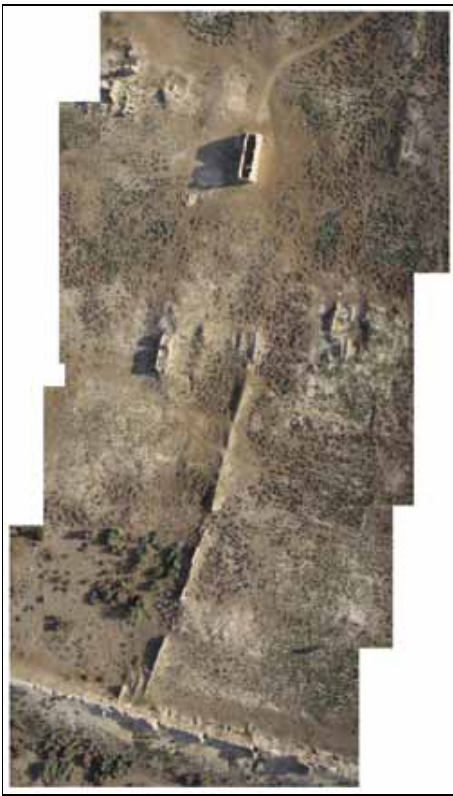
Fig. 12: A manually constructed photo-mosaic of an area within the citadel of Shahri- yar